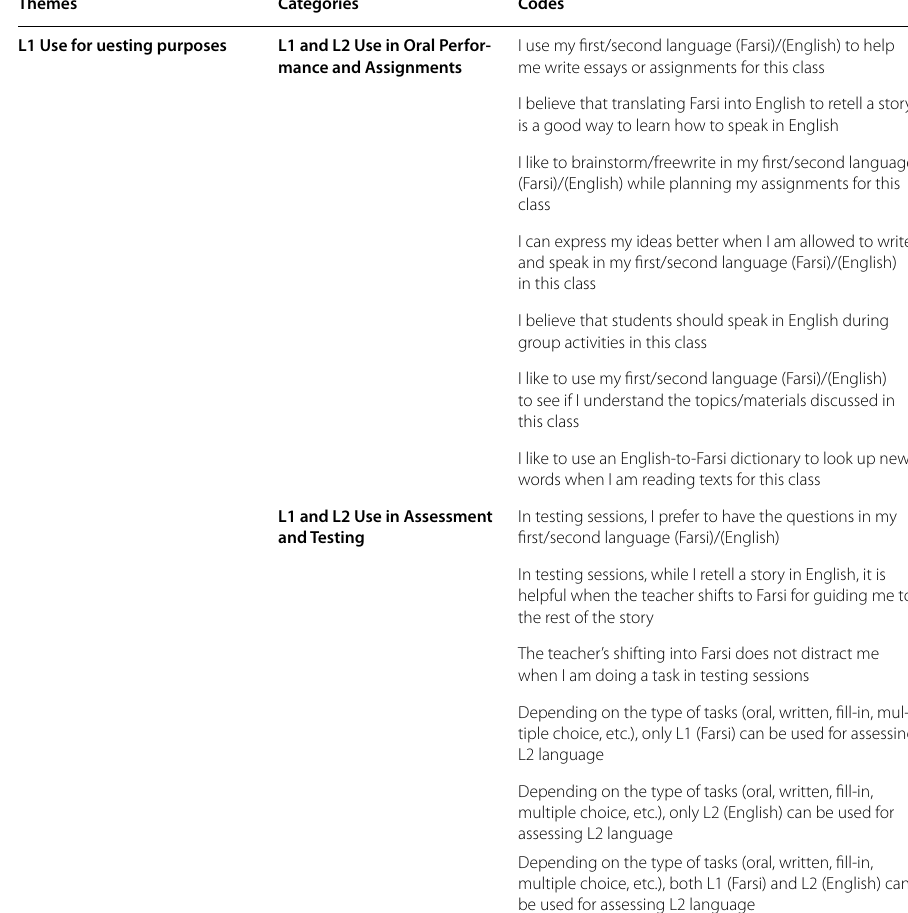
Table 2 displays Cronbach’s alpha reliability for the L1 and L2 questionnaires piloted on a group of 40 students (20 students for L1 and 20 students for L2). The reliabil- ity indices for the subsections of the questionnaire for L1 and L2 use were as fol- lows: permission ( L1 0.733; L2 0.874 ), general ( L1 0.800; L2 0.611 ), others = = = = ( L1 0.847; L2 0.693 ), oral performance ( L1 0.733; L2 0.874 ), and assessment = = = = Table 2 Reliability statistics of L1 and L2 questionnaires (pilot study) L1 & L2 use L1 L2 No. of items Permission 0.733 General 0.800 Others Oral performance